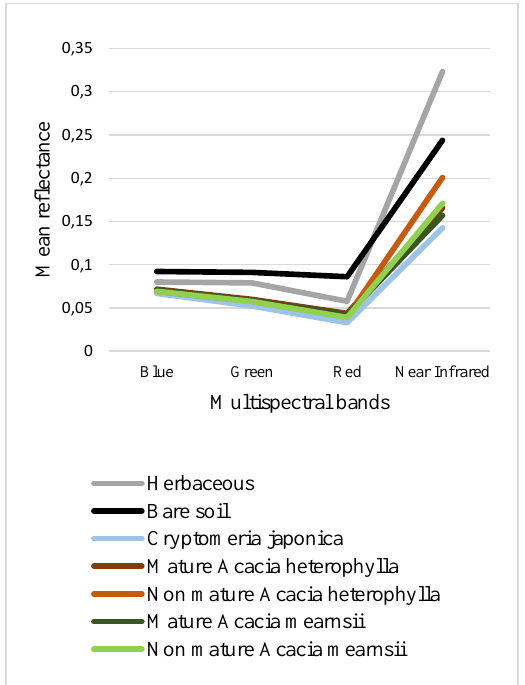
Figure 5. Multispectral signatures